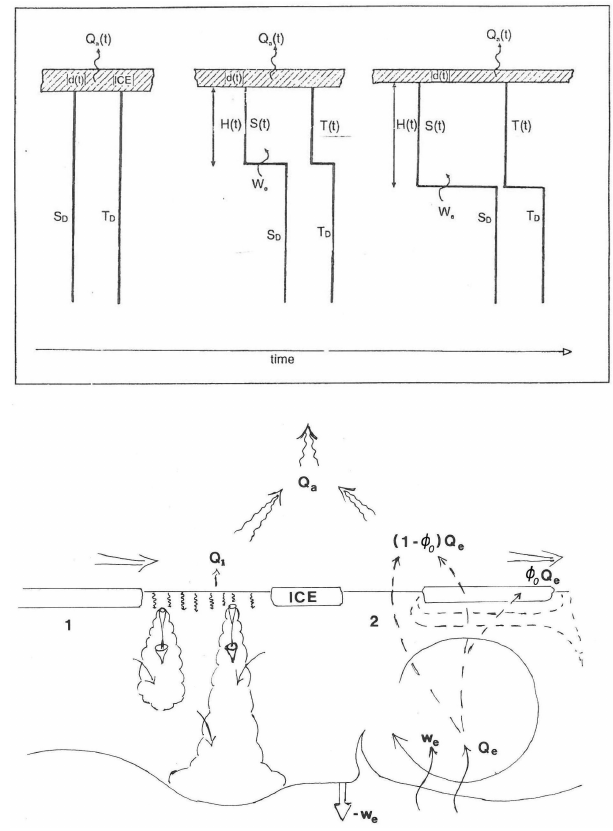
Fig. 5. Upper panel: the evolution of the upper layer, when warm water encounters sea ice under freezing conditions. From Rudels et al., 1999a. Lower Panel: schematics showing oceanic heat loss under freezing conditions and in the presence of sea ice. From Rudels